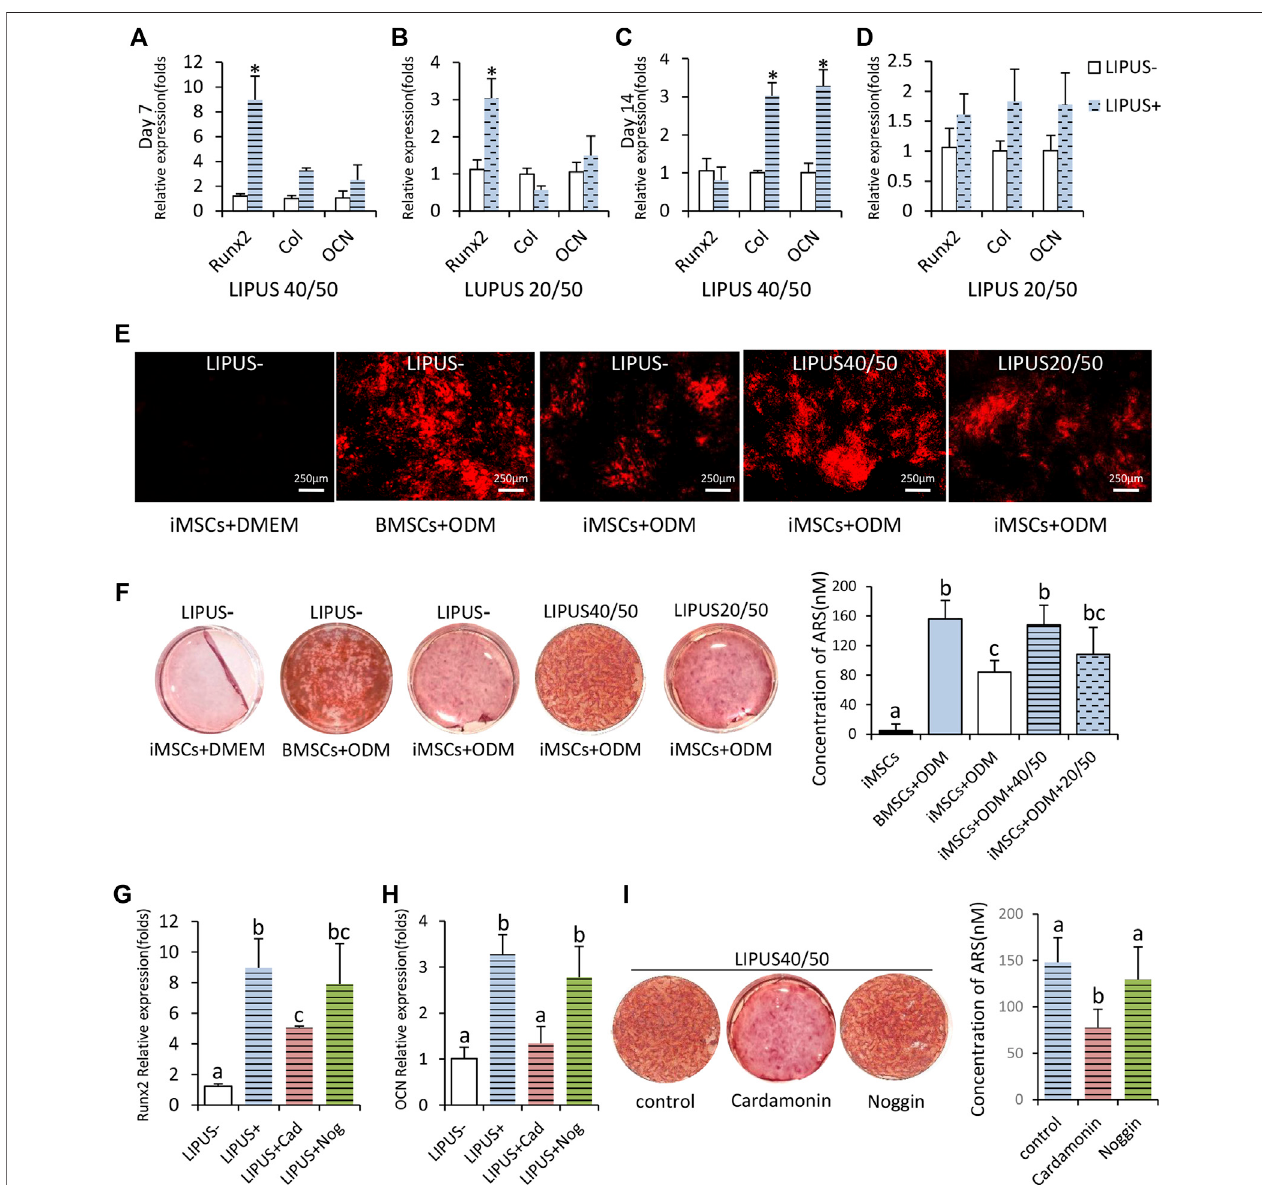
FIGURE2| OsteogenicpotentialofiMSCsunderthestimulationofLIPUS40/50 invitro . (A – D) FoldchangesintheexpressionlevelofRunx2,Col,andOCN.IMSCs underwent osteogenic differentiation with/without the LIPUS stimulation, n = 3. Data are presented as mean ± SD, * p ＜ 0.05. (E) Xylenol orange staining; LIPUS40/50 greatly increased the positive staining area. (F,I) Alizarin Red staining and mineralization quanti fi cation. Data are presented as mean ± SD, n = 3. Bars with dissimilar letters indicated signi fi cantly different values ( p < 0.05). (G,H) Fold changes in the expression level of Runx2 and OCN, n = 3. Bars with dissimilar letters indicated signi fi cantly different values ( p <